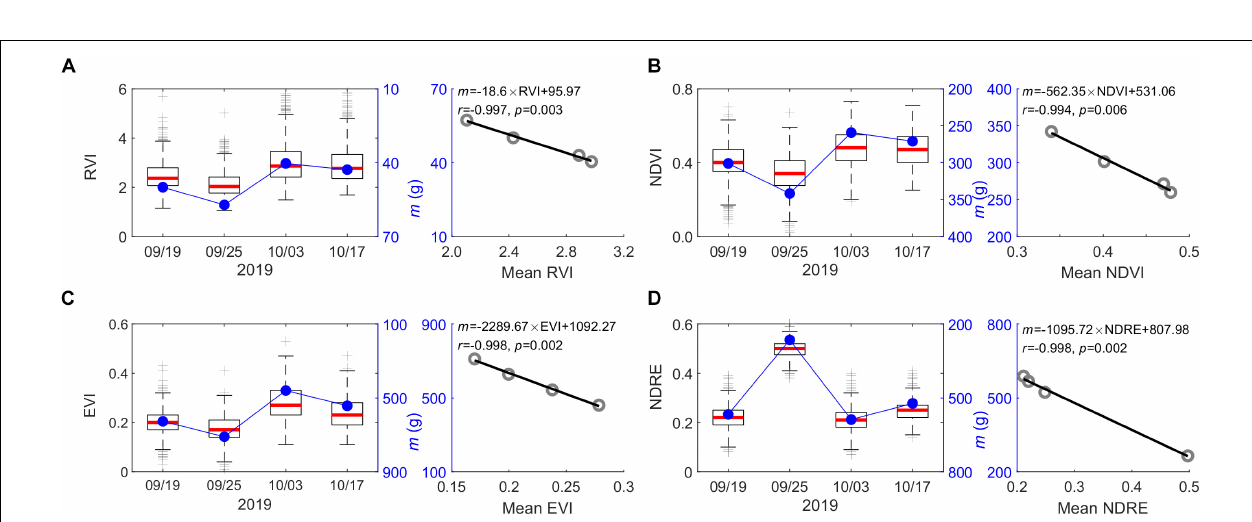
FIGURE 10 | Relationship between the coefficient of m in UAV-biomass models and plant phenotype changes qualified by the various spectral indices from the early peak season to the end of the growing season. (A) RVI; (B) NDVI; (C) EVI; and (D) NDRE. Time-specific variations of the spectral index for the 1,320 switchgrass plants in the field are reflected by boxplot statistics, where the red line on the box indicates the median, and the bottom and top edges of the box indicate the 25 th and 75 th percentiles, respectively.